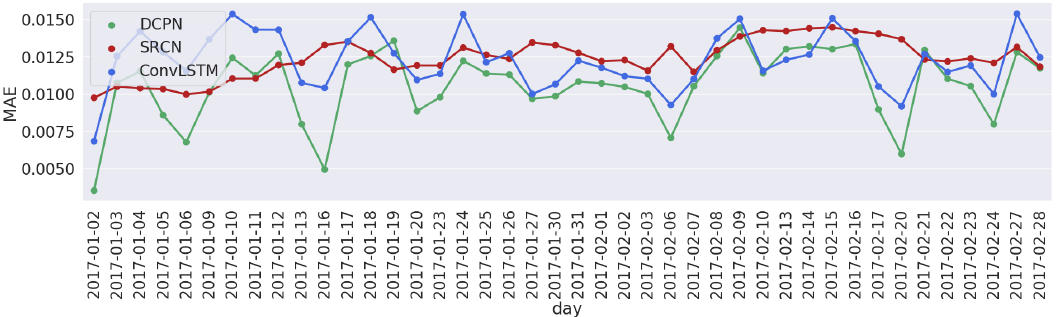
Figure 4. Daily total wMSE errors with a prediction horizon of 10 min on 42 days evaluated with back-testing.